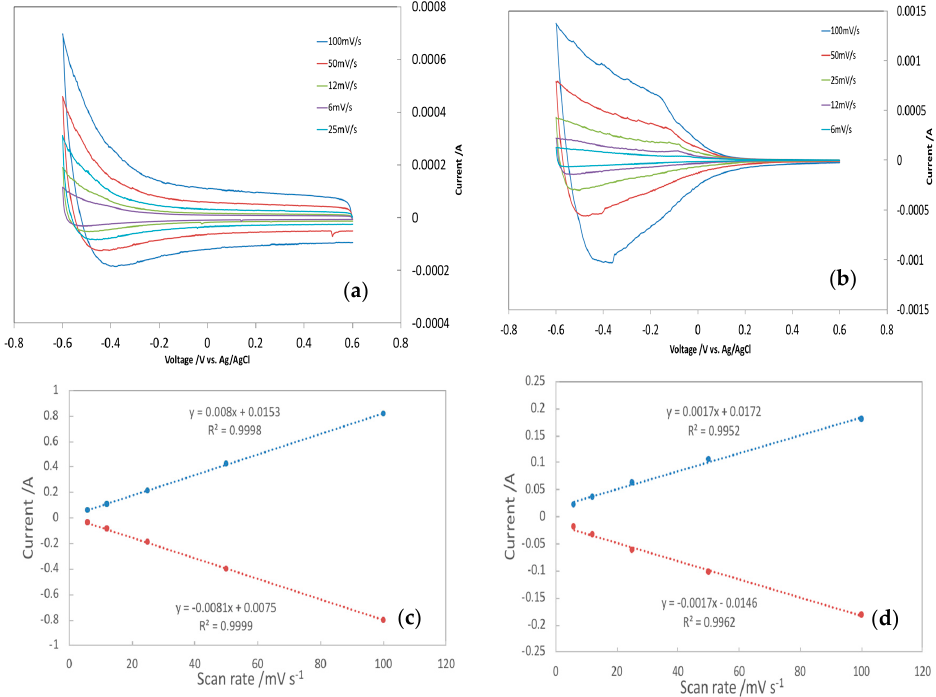
Figure 4. Cyclic voltammograms 1 M NaCl at various scan rates for ( a ) TiO 2 NT-NA; ( b ) TiO 2 NT-A; and EDL capacitance calculations for the determination of EASA ( c ) TiO 2 NT-NA; ( d ) TiO 2 NT-A. For the determination of EDL capacitance, charging currents measured at − 0.3 V vs. Ag/AgCl, plotted as a function of the scan rate from Figure 4a,d, cathodic and anodic charging currents measured at − 0.3 V vs. Ag/AgCl, plotted as a function of scan